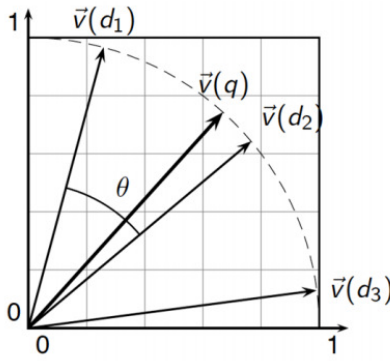
Figure 5. Cosine similarity between